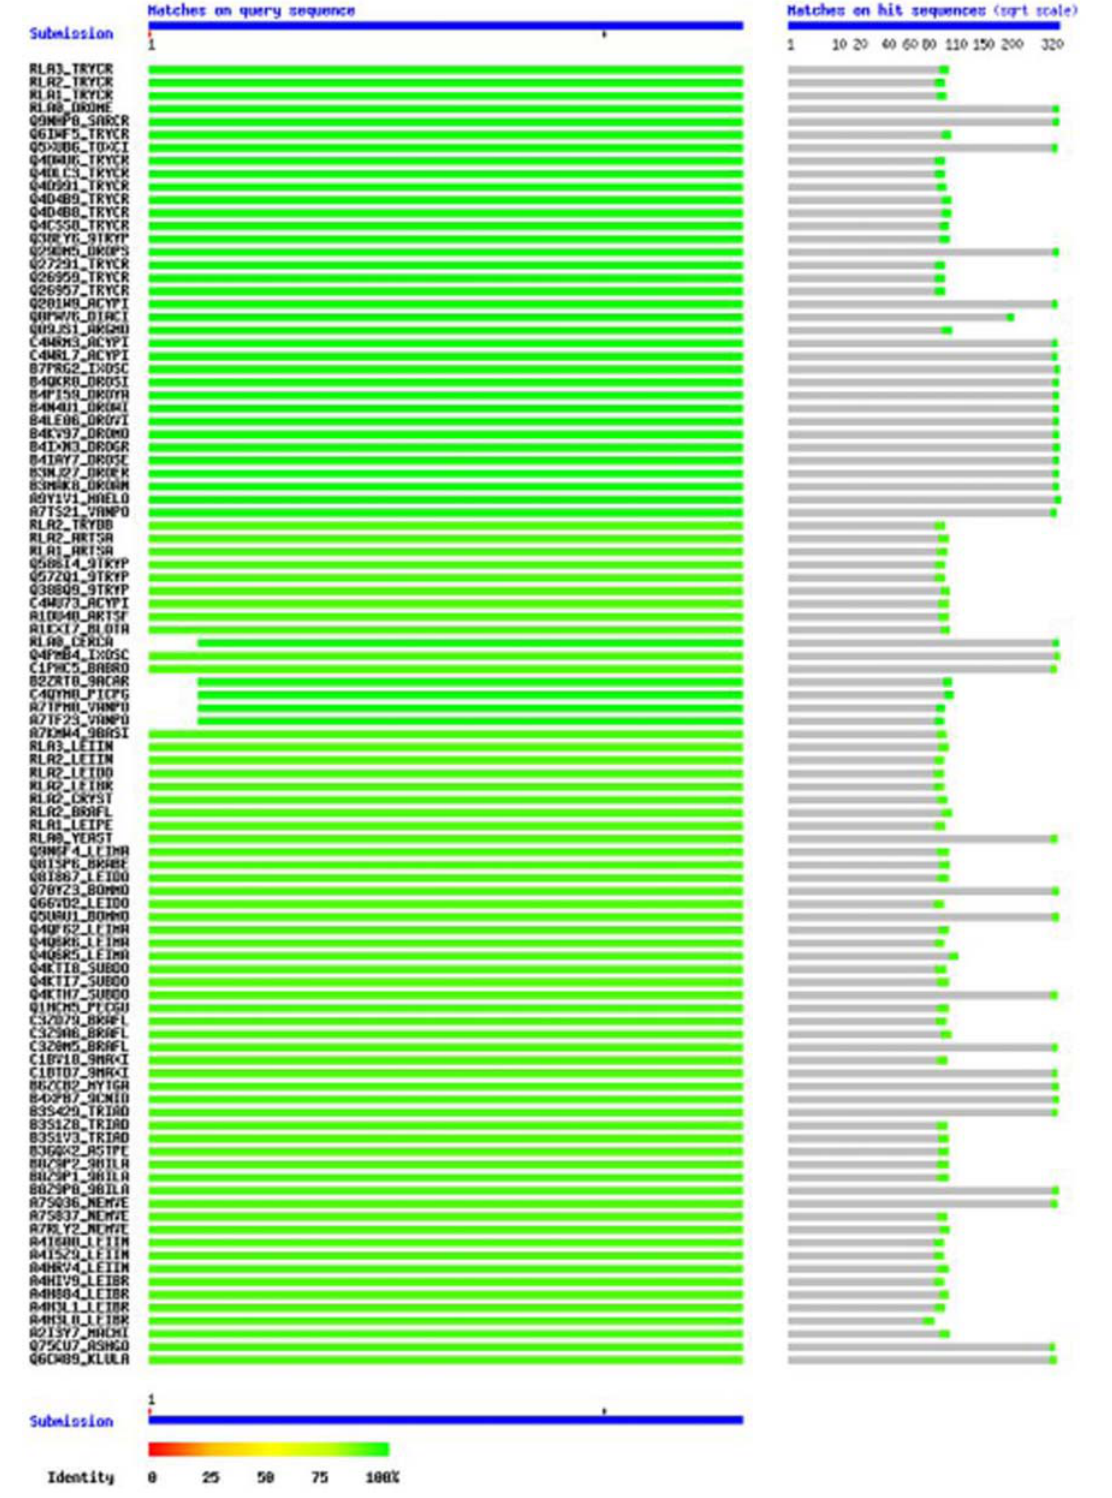
Figure 2. Showing the schematics of the BLAST hits obtained by querying the C-termini of TcP2 b across a Swiss Prot database using the BLAST tool at SIB. The Figure illustrates the schematics of the Scores and E values of hits obtained by querying the 13 amino acid sequences of the C-termini of TcP2 b (EEEDDDMGFGLFD) across a Swiss Prot database using the BLAST tool at SIB. Note the presence of a key at the bottom to annotate meaning to the colors. Interpretation of this schematics may be best done with table 2 and supplementing file 2 in hand. Briefly, % identity of hits declines as the green color (signifying 100% identity) fades from green to finally red (signifying 0% identity).The data was generated by the BLAST tool at the following URL: SIB availablehttp://www.expasy.ch/cgi-bin/blast.pl